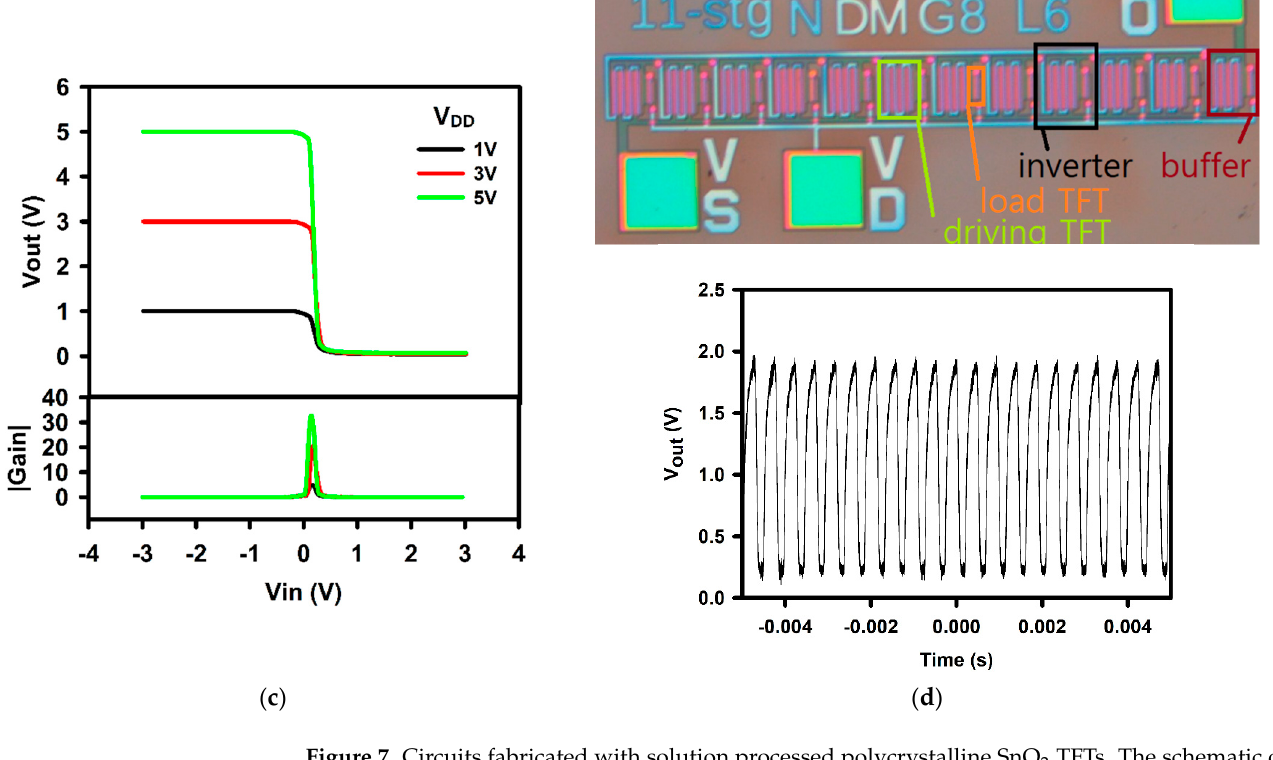
Figure 7. Circuits fabricated with solution processed polycrystalline SnO 2 TFTs. The schematic of ( a ) an inverter and ( b ) a ring oscillator (R.O.). ( c ) The output curve of an inverter ( top ) and its gain ( bottom ). ( d ) The optical image ( top ) and the output curve of a R.O. ( bottom ).